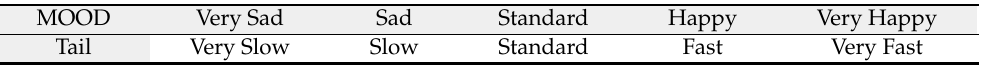
Table 9. Table of MOOD/tail rules. The gray cells represent the different MOOD labels and the Tail